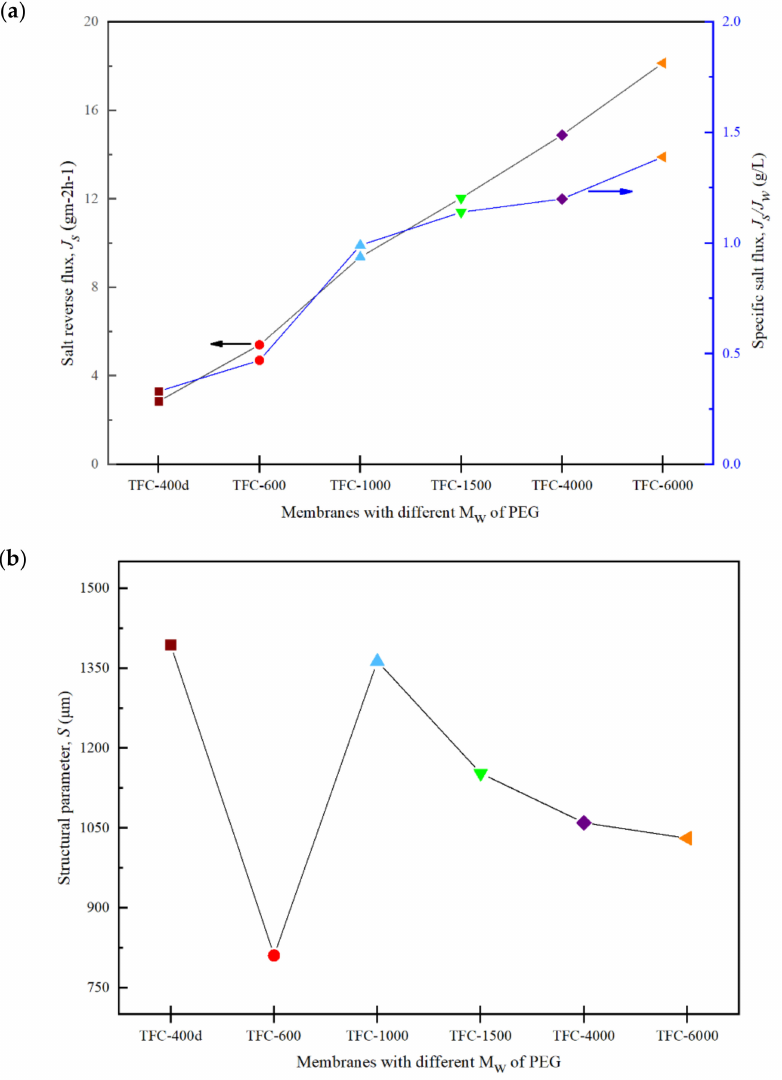
Figure 11. ( a ) Salt reverse-flux, J s , and specific salt flux, J s / J w ; and ( b ) structural parameter, S , of the modified TFC membranes with different M w s of PEG in FO